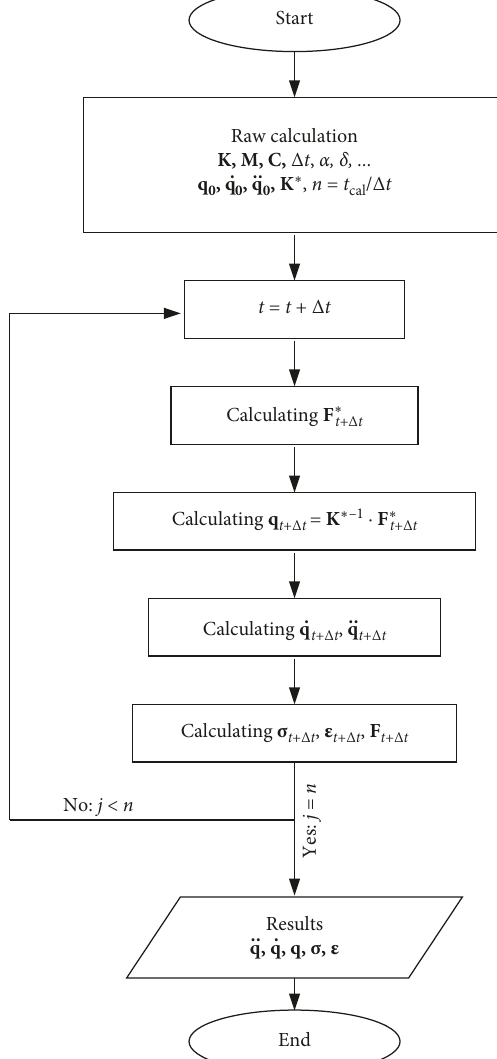
Figure 2: Flowchart of Newmark-beta method for solving the dynamic response problem of the